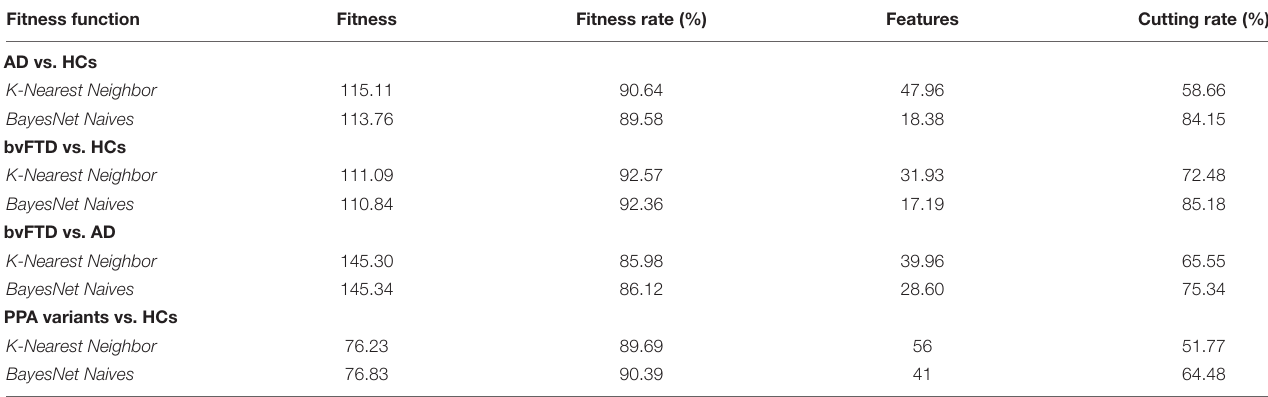
TABLE 2 | Average results for FDG-PET imaging